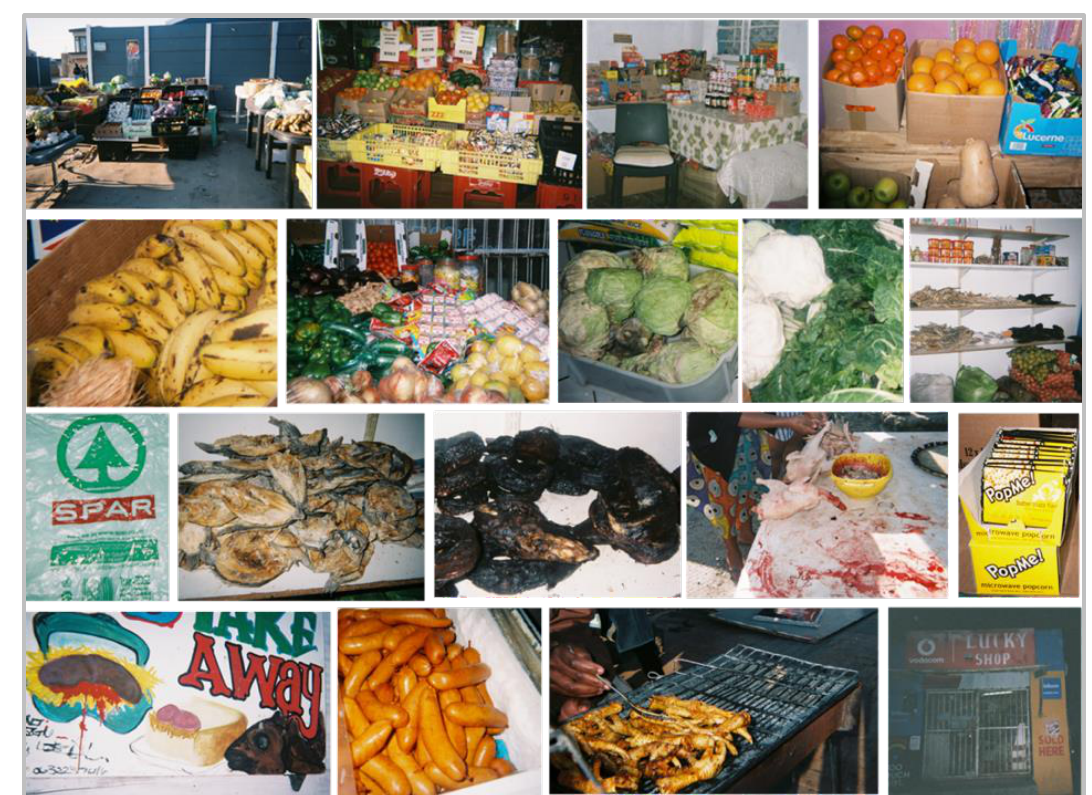
Figure 3. Photographs taken by grade seven learners of food shops, informal vendors and take-away options in their community environment.